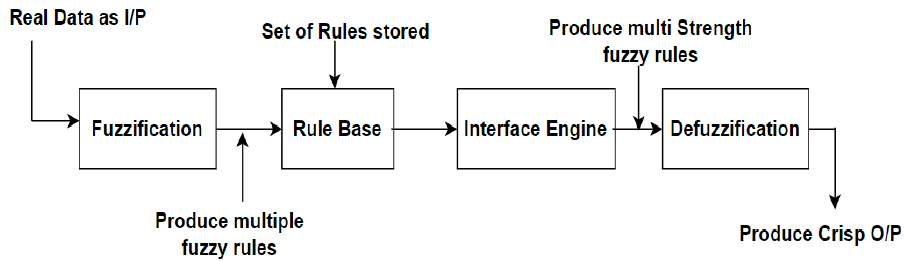
Figure 3. Components of a fuzzy controller.